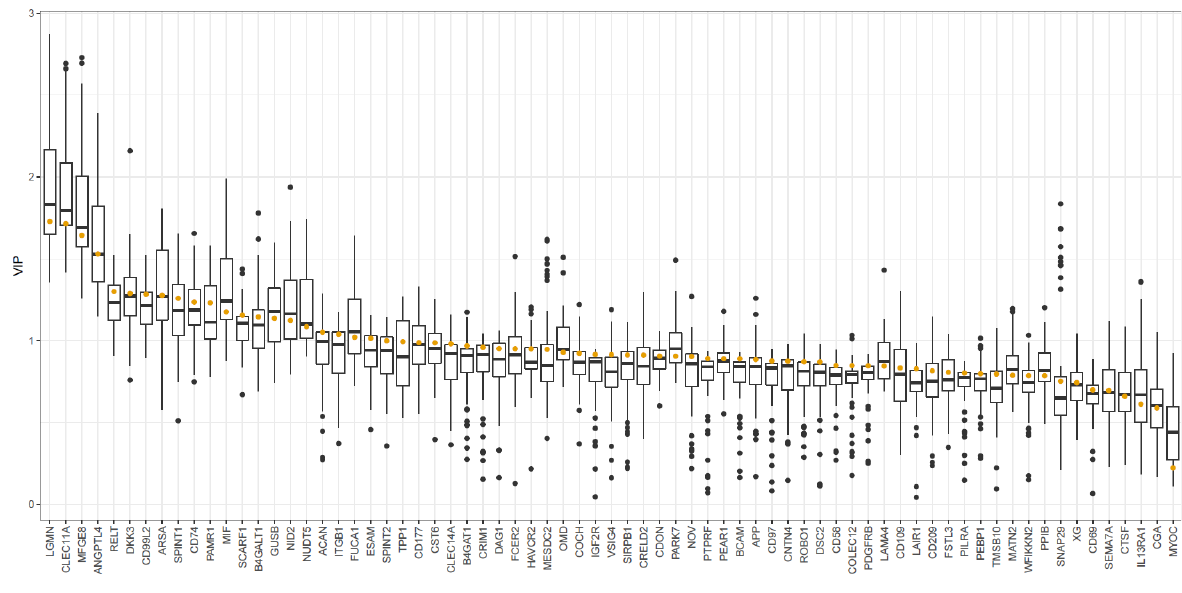
Figure 3. CSF biomarkers in TN patients and controls — a PLS-DA VIP analysis. The figure demon- strates the VIP values for clinical and biomarker variables in the PLS-DA model predicting patient or control CSF samples based on PEA data. The yellow dots represent the VIP for the full model (based on all data). The boxplots represent the VIP for the cross-validated models.